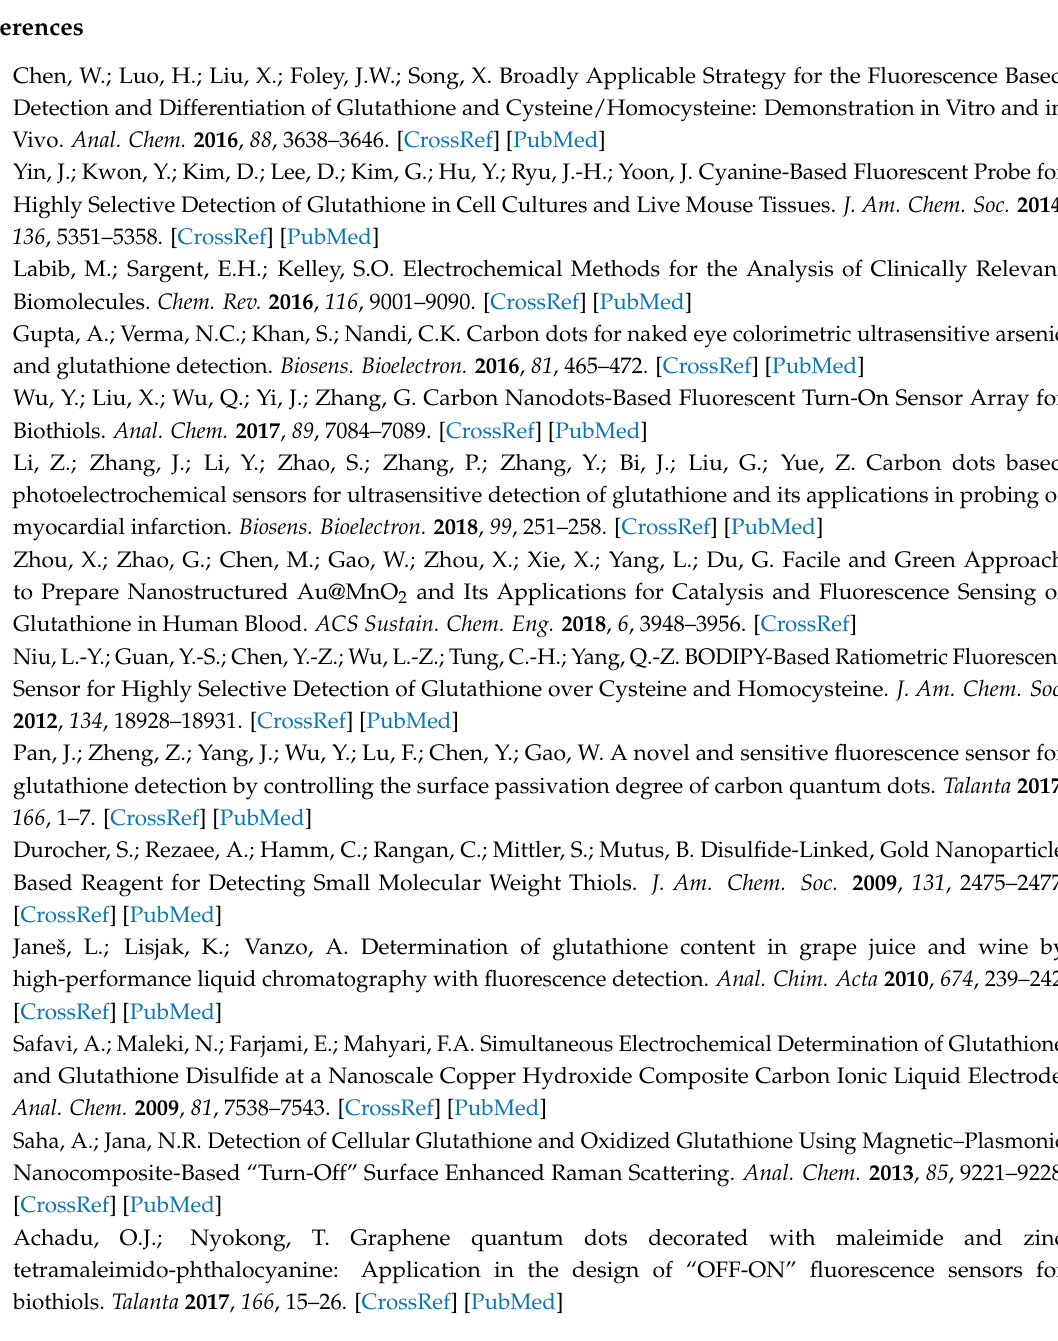
Table S1: QY calculation of N-CNPs, Table S2: The comparison between various CNPs and CDs toward Fe(III), Table S3: The comparison between various fluorescent sensors based on CNPs or CDs toward